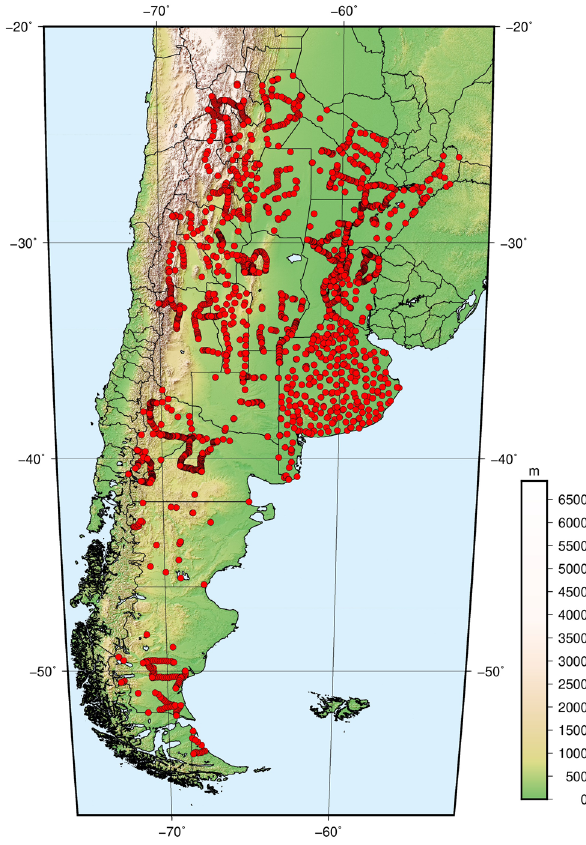
Figure 1: Distribution of the GPS/levelling benchmarks in Argentina. The topography is also included, noting its variability along the country.